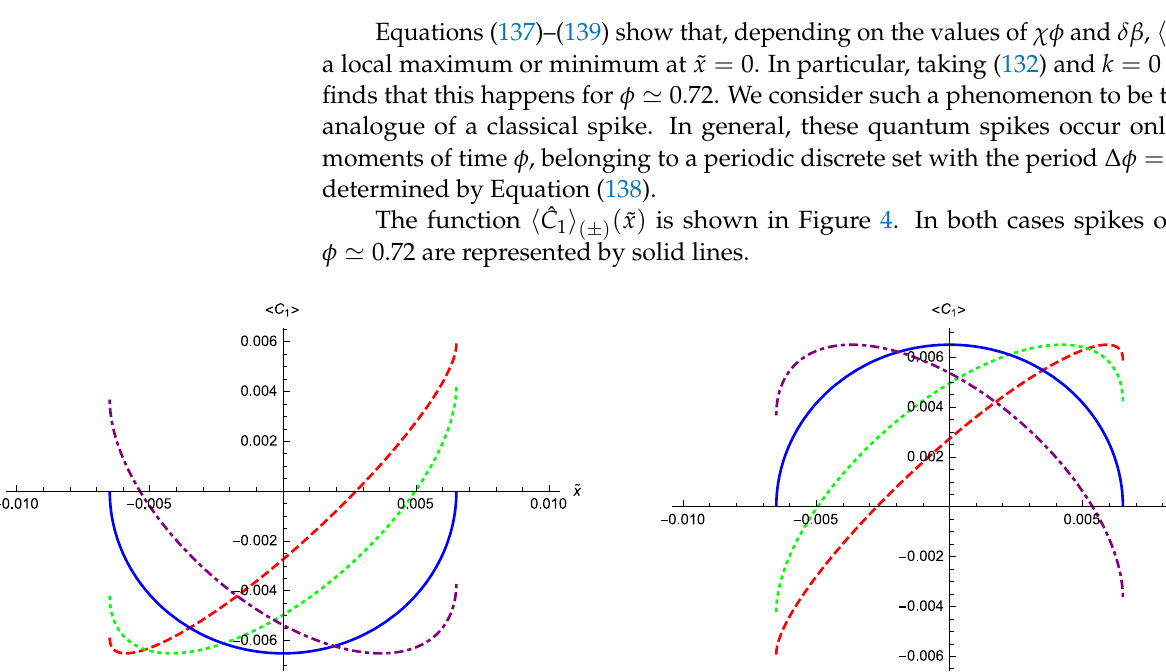
Figure 4. (cid:104) ˆ C 1 (cid:105) ( − ) (left) and (cid:104) ˆ C 1 (cid:105) (+) (right) for evolution parameters φ = 0.2 (dashed), φ = 0.4 (dotted), φ = 0.72 (solid) and φ = 1